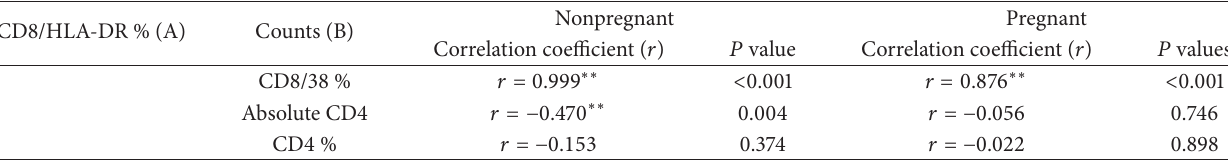
Table 5: Relationship between CD8/38 and the CD4 + cell counts (statistical analysis by Pearson correlation (Sig. (2 tailed))). Nonpregnant Pregnant CD8/38 % (A) Counts (B) Correlation coefficient ( 𝑟 ) 𝑃 value Correlation coefficient ( 𝑟 ) 𝑃 values Absolute CD4 𝑟 = −0.478 ∗∗ 0.003 𝑟 = −0.277 0.102 CD4 % 𝑟 = −0.154 0.370 𝑟 = −0.162 0.345 A: CD8/38 cellular immune activation markers; B: CD4 cell counts. ∗∗ Correlation is significant at the 0.01 level (2 tailed). ∗ Correlation is significant at the 0.05 level (2